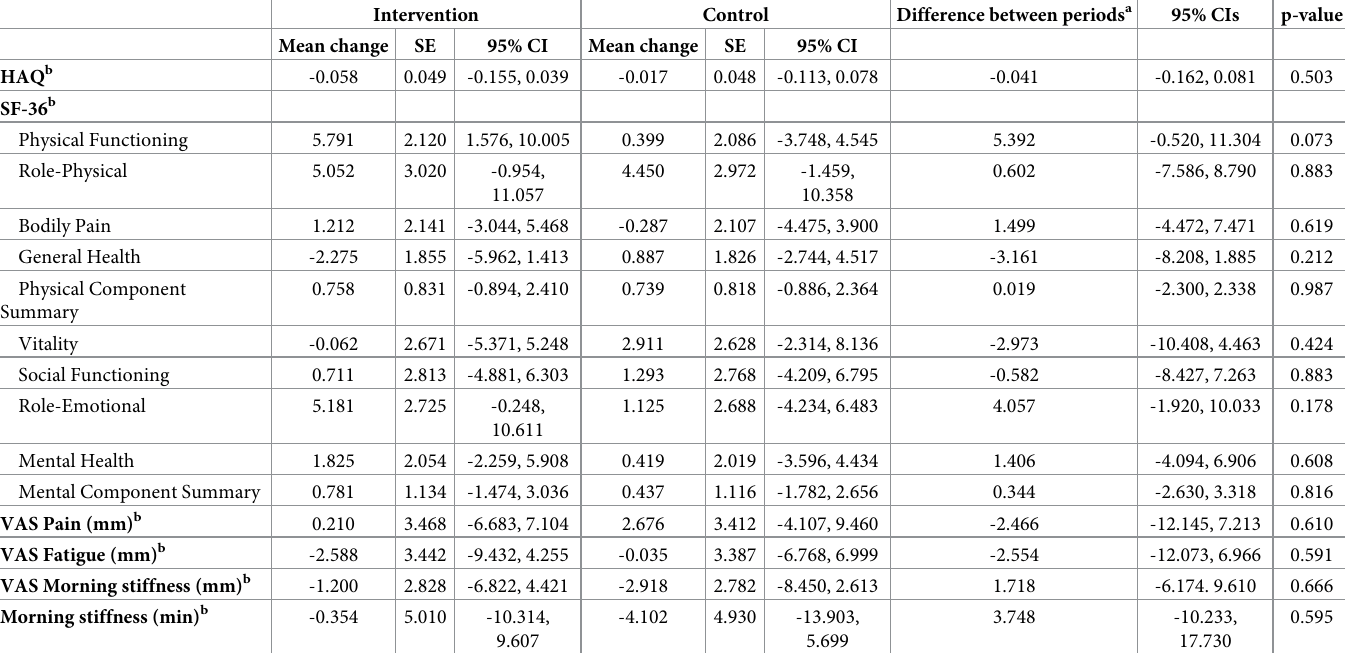
Table 3. The effects on HrQoL in the ADIRA